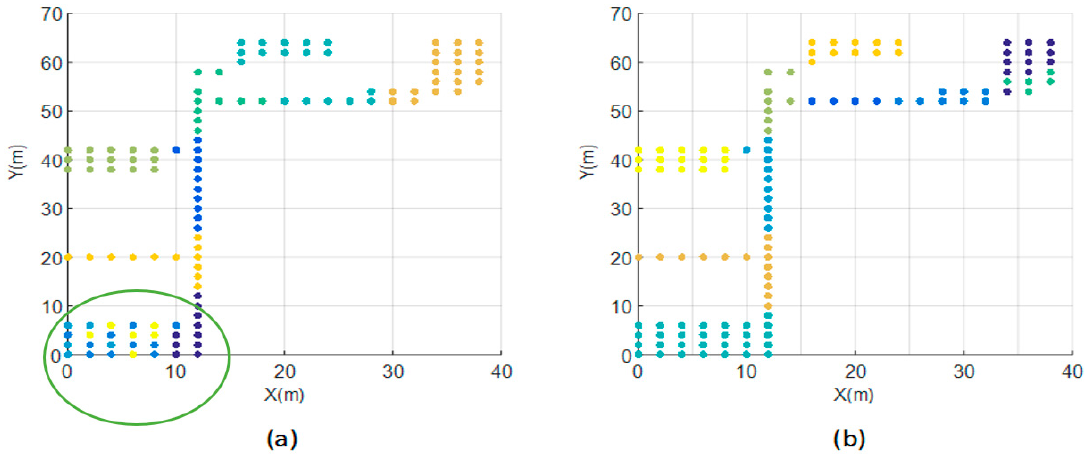
Figure 10. K-means clustering. ( a ) With a single SSID; ( b ) with multiple SSIDs.